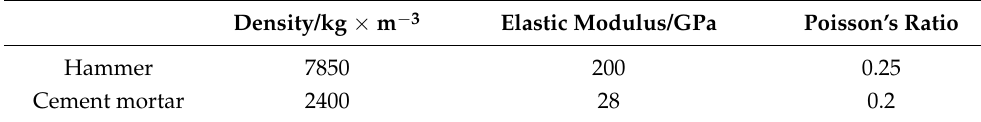
Table 1. Constitutive parameters of block elements.